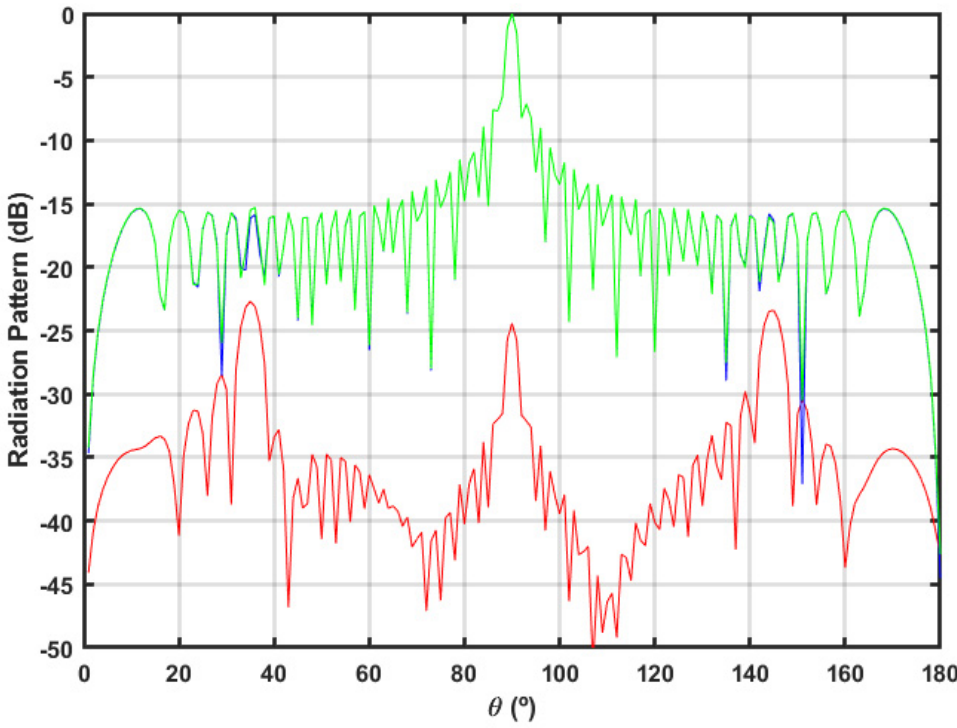
Figure 15. Radiation Pattern (RP) of RACD with 48 antennas case Table 2-(1) step = 0.12 m: (—) RP without helix. (—) Parasitic RP of helix. (—) Total RP.